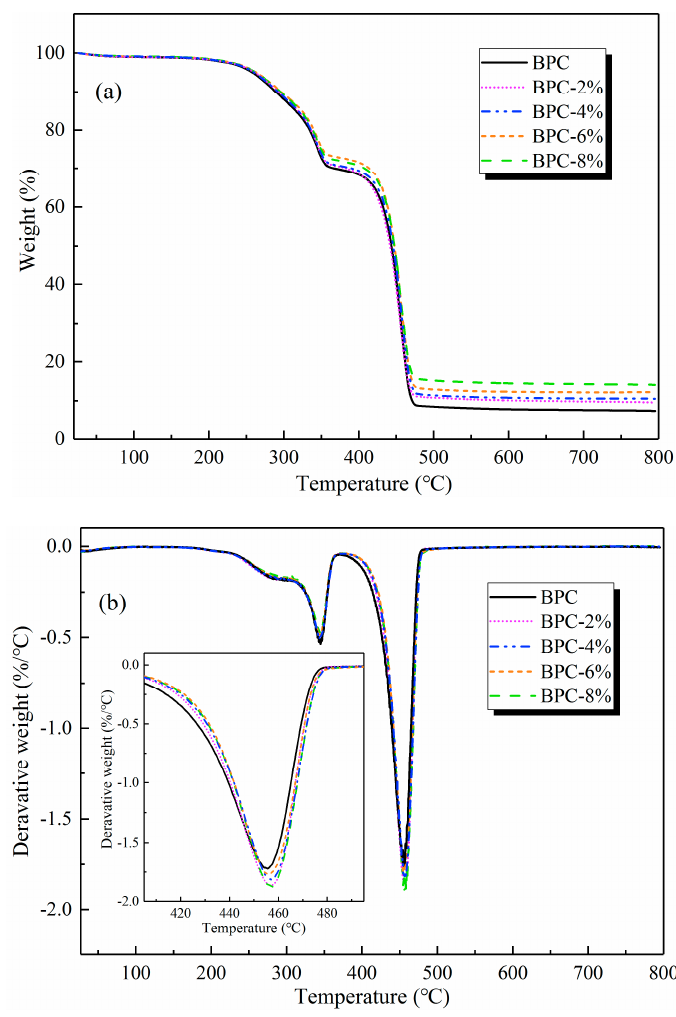
Figure 4. Thermogravimetric analysis of the BPCs: ( a ) TGA and ( b ) DTG.